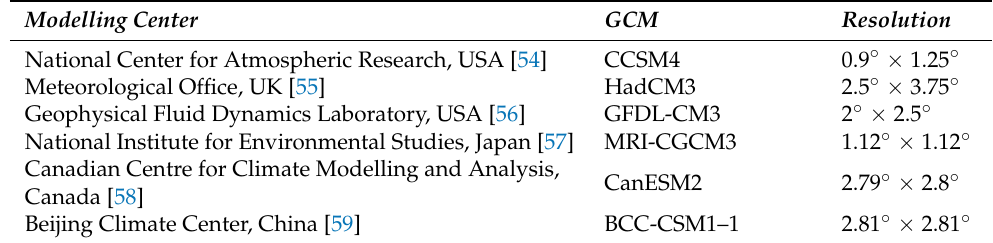
Table 1. Selected GCMs from CMIP5.